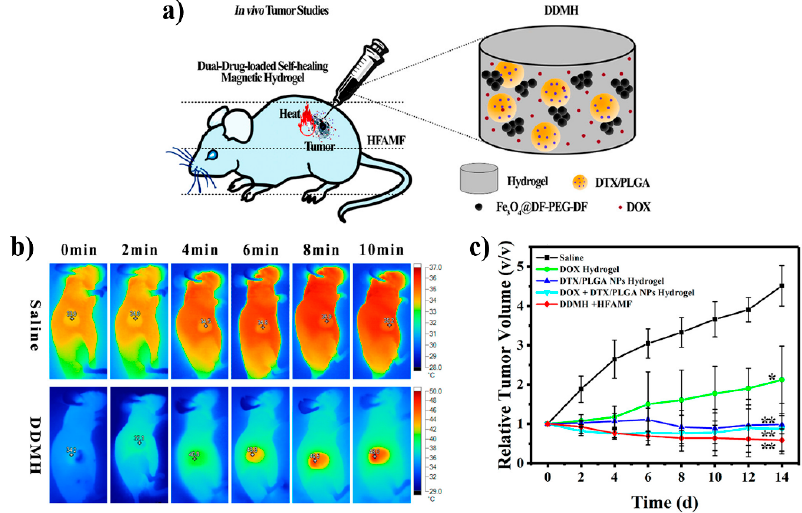
Figure 8. ( a ) Schematic illustration of dual-drug-loaded magnetic hydrogel (DDMH) for cancer treatment; ( b ) infrared thermal image for tumor-bearing mice exposed to an AMF (19.99 KA/m) for 10 min at post-injection of saline and DDMH (100 μ L); and ( c ) tumor growth curves with different treatments (saline group, DOX group, DTX/PLGA NPs group, DOX + DTX/PLGA NPs group, and DDMH + AMF group). Data presented the mean ± standard deviation of five mice. Reprinted with permission [47]. Copyright 2015, American Chemical